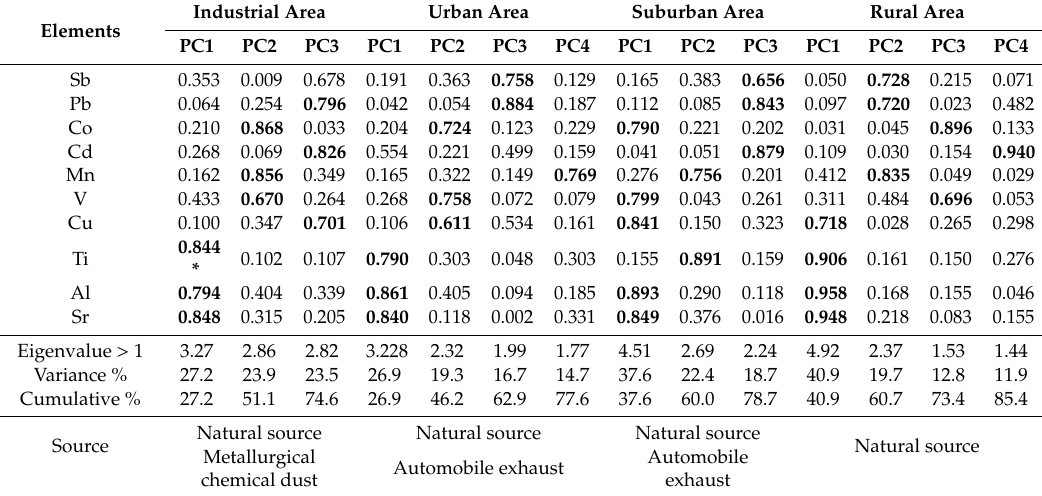
Table 4. Results of principal component analysis (PCA) of heavy metals in PM 2.5 from industrial, urban, suburban, and rural areas of Nanjing,